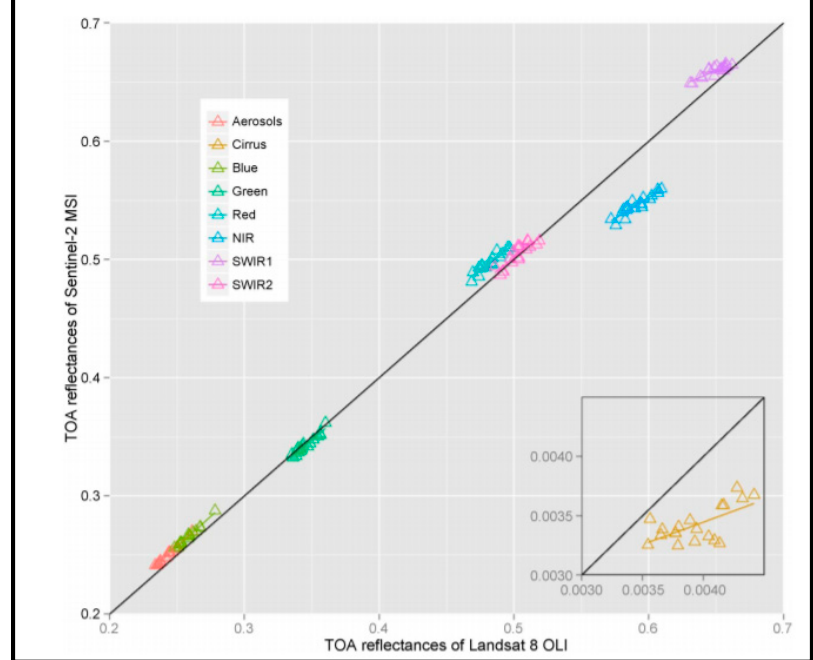
Figure 4. TOA reflectances of MSI and OLI. Cirrus band comparison is at lower right corner. [79].